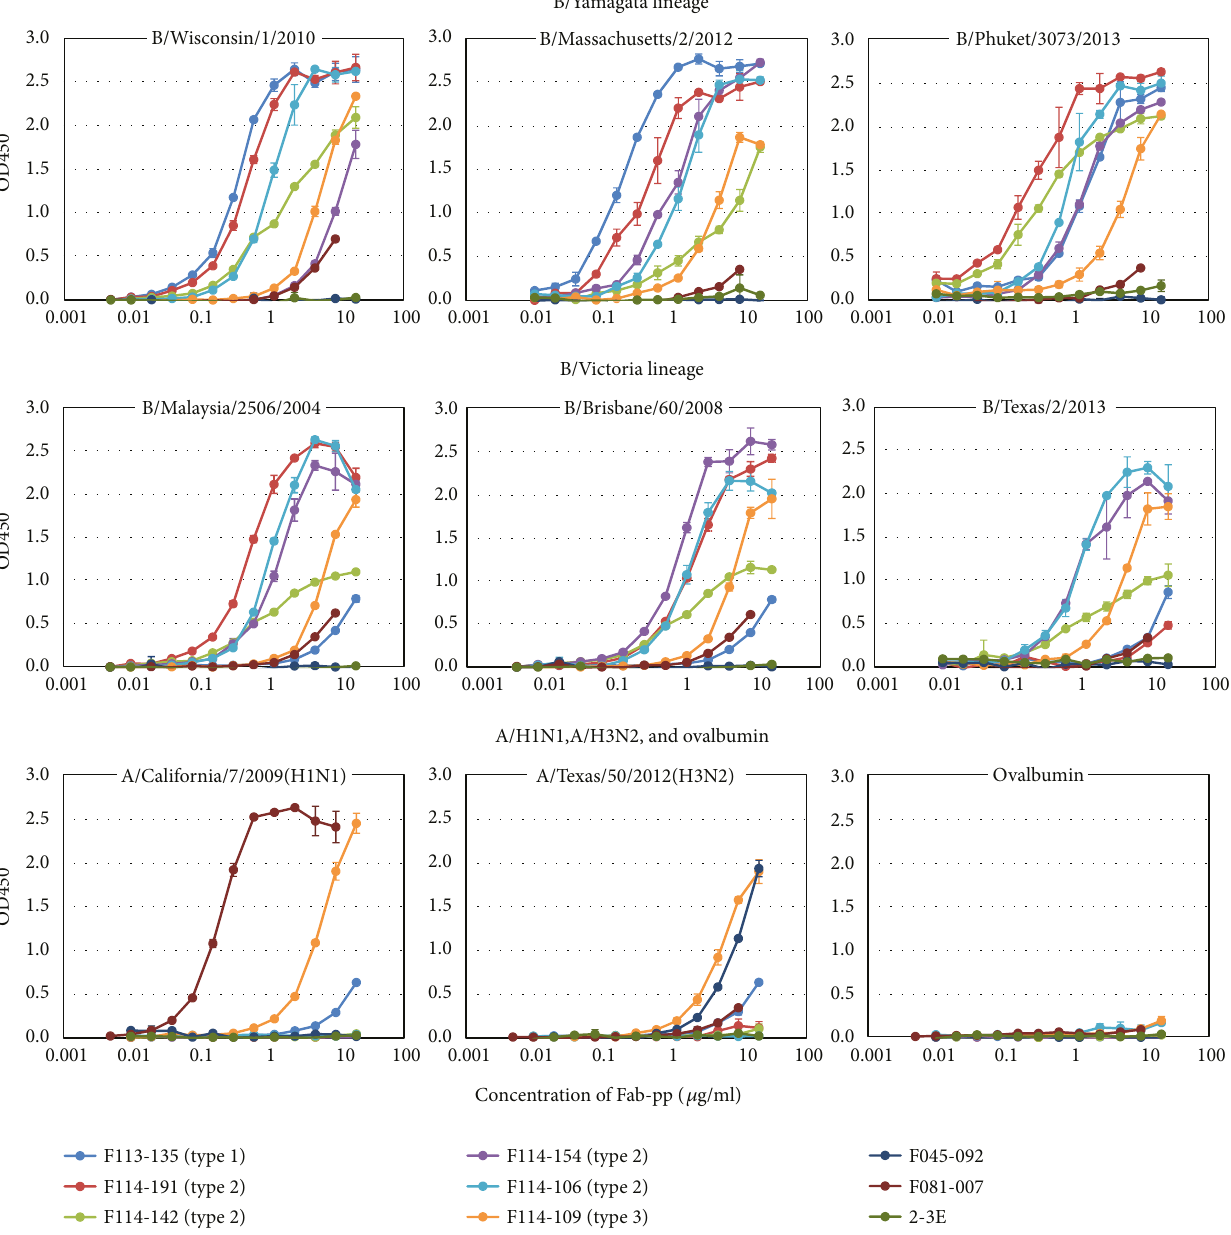
Figure 4: Titration of binding activity of representative Abs against various kinds of in fl uenza viruses. Puri fi ed Fab-PP form of Abs, F113-135 (type 1), F114-191, F114-142, F114-154, F114-106 (type 2), F114-109 (type 3), F045-092 (anti-H3 Ab), F081-007 (anti-H1 Ab), and 2-3E (anti-VP4 of rotavirus antibody) were utilized in this experiment. The binding activities to six kinds of in fl uenza B virus, one H1N1 virus, one H3N2 virus, and ovalbumin (negative control) were examined under various